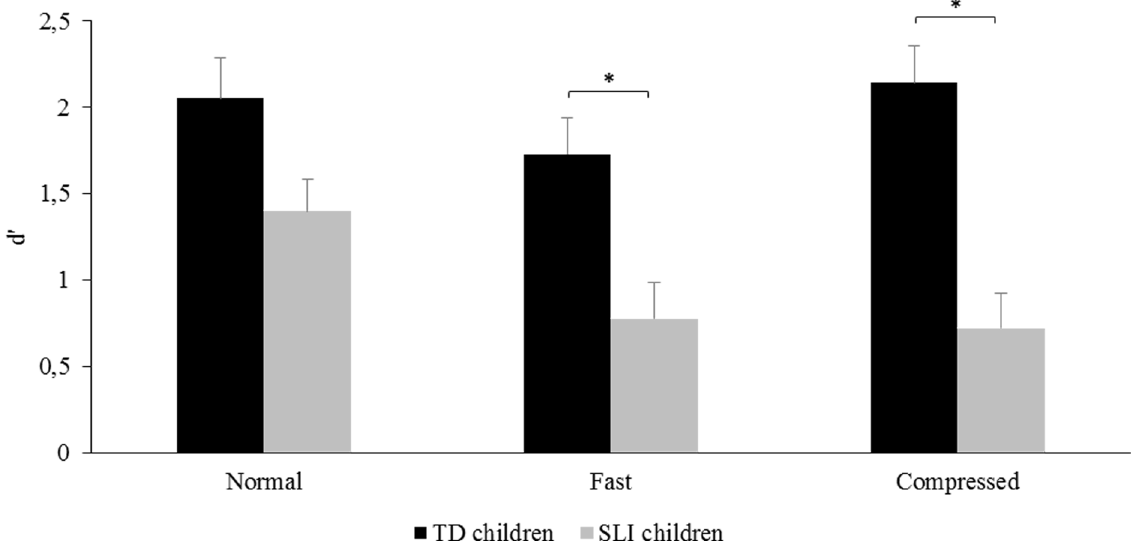
Fig 1. Children’s sensitivity to semantic incongruity during normal and fast rate speech processing. Mean d 0 values in children with SLI and in chronological age-matched typically-developing (TD) children are presented as a function of Speech Rate (natural normal, natural fast and time-compressed). ( (cid:3) ) indicates a significant difference between conditions ( p < .05). Error bars indicate standard errors.